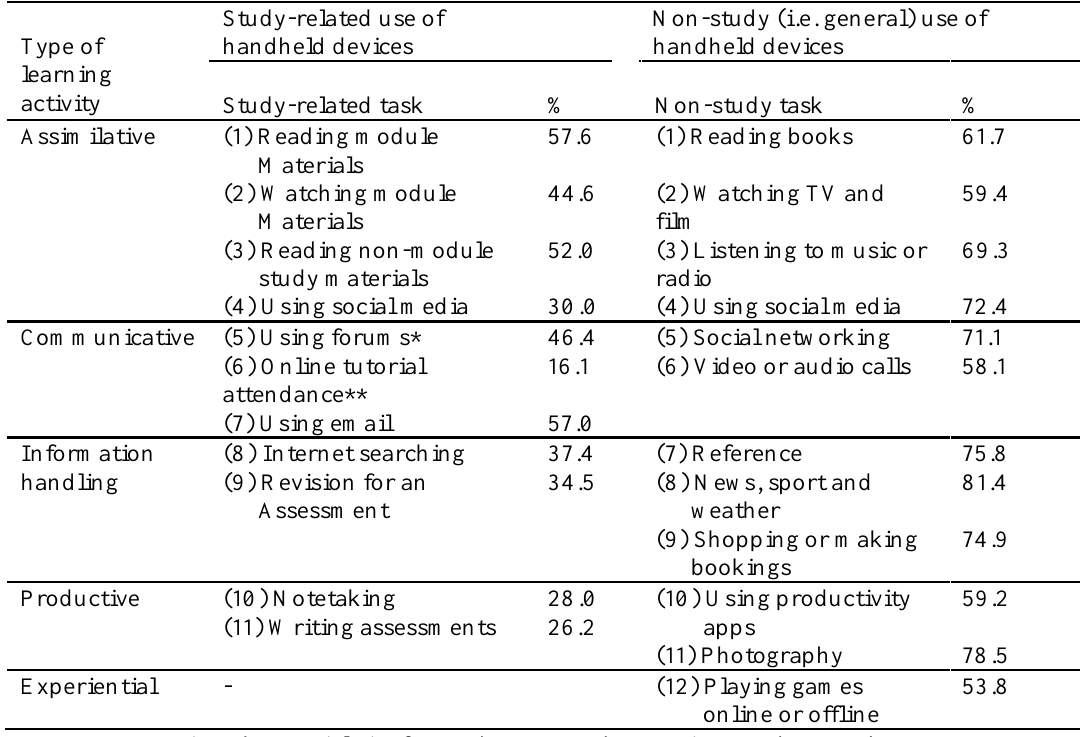
Proportion of Students Using Handheld Devices for Study-Related Learning Tasks and the Proportion Using Handheld Devices for Non-Study Tasks (n=446)